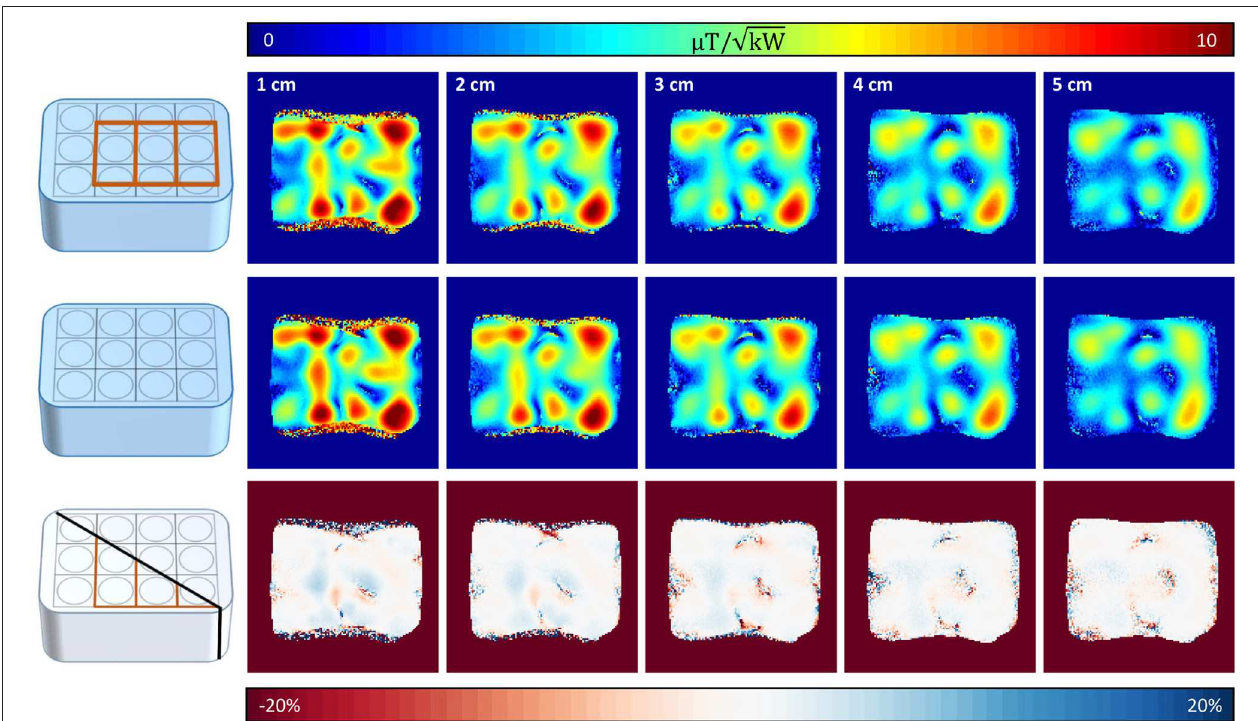
FIGURE 5 | Coronal 1 H B + 1 maps with and without 31 P array present. Top row shows coronal B + 1 slices (10mm slice thickness, distance from surface/RF coil 1–5cm) with the 31 P array positioned below the proton array, whereas in the middle row the same slices are shown without the 31 P array present. Bottom row shows the resulting difference of the B + 1 maps above. Highest deviations are encountered where the B + 1 mapping sequence produced artifacts due to the high B + 1 of surface coils.